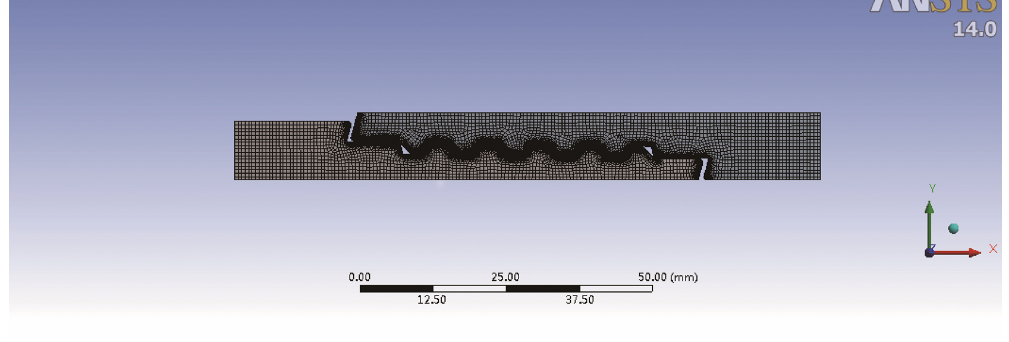
Figure 10. The scale model.